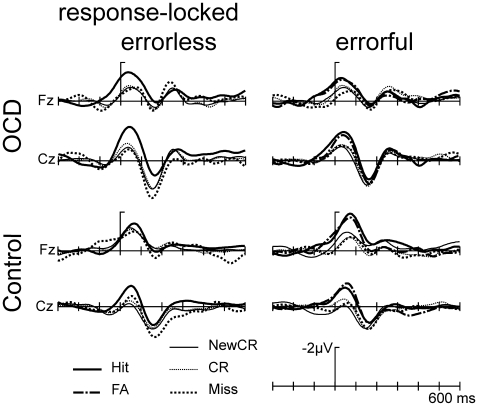
Response-locked potentials for OCD- and control-group.Response-locked ERPs (negativity is plotted up and each hash mark represents 100 ms of activity in this and in the following figures) of OCD patients (upper panel, N = 16) and control group (lower panel, N = 16). Hits related to both learning conditions and errorful false alarms result in an increased negativity compared to misses and both correct rejections. For the errorless mode (left panel) this is enhanced for OCD as compared to control group. For the errorful condition the opposite is true (most prominent at Fz).